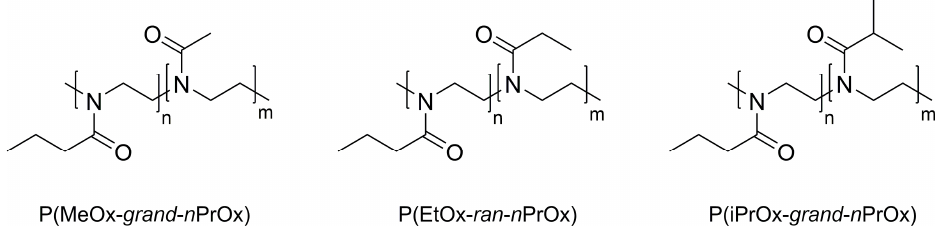
Figure 15. The structures of synthesized copolymers. Adapted from [14].